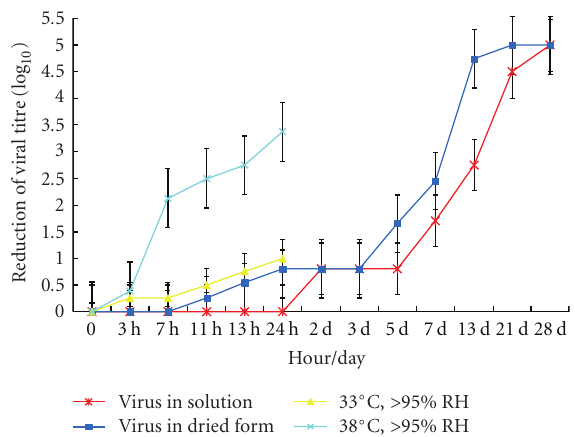
Figure 1: Residual virus infectivity at 22–25 ◦ C with relative humi- dity 40–50% (starting titre 10 5 /10 μ L) and at 33 ◦ C or 38 ◦ C with re- lative humidity >